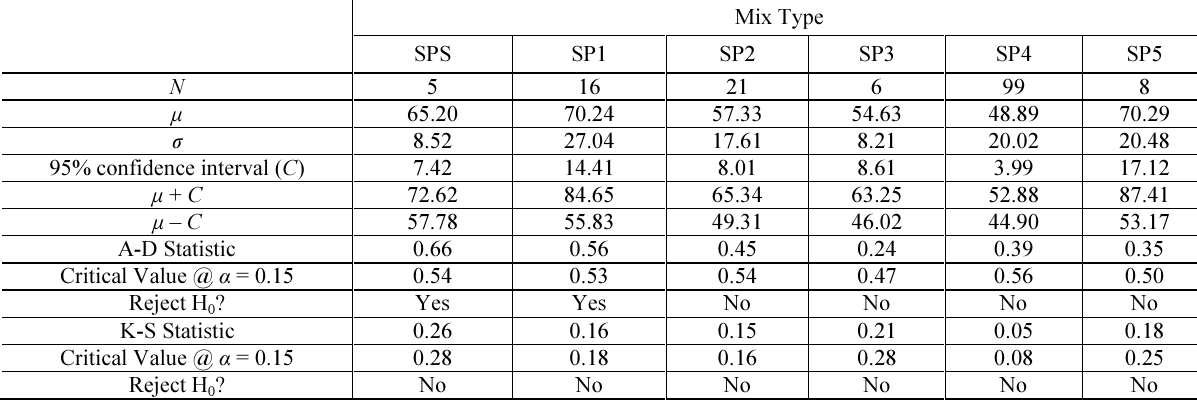
Table 1. Normality Test of AV for contractor